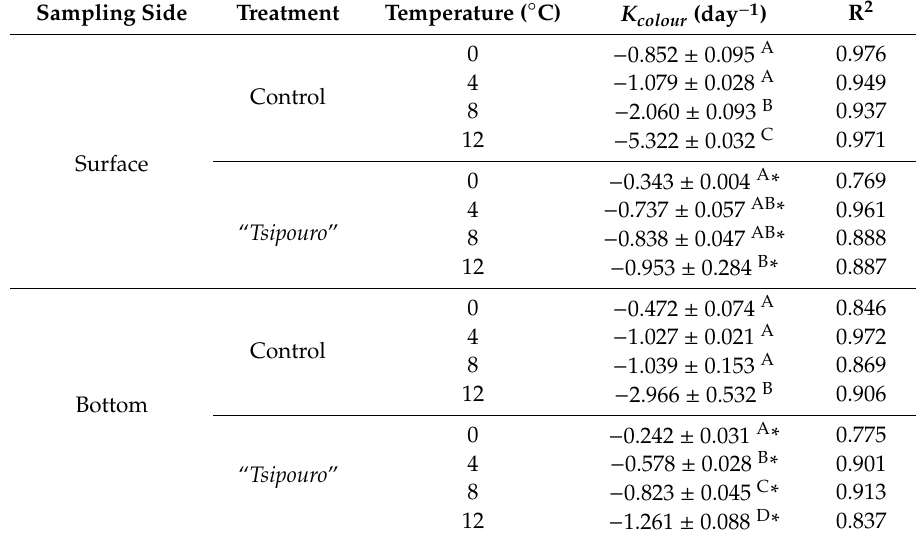
k colour values within the same treatment and sampling side having di ff erent uppercase letter are significantly di ff erent from each other ( p < 0.05); Star indicates statistical significance of “ tsipouro ” treatment in comparison to controls under the same conditions (sampling side and storage temperature) (*: p <